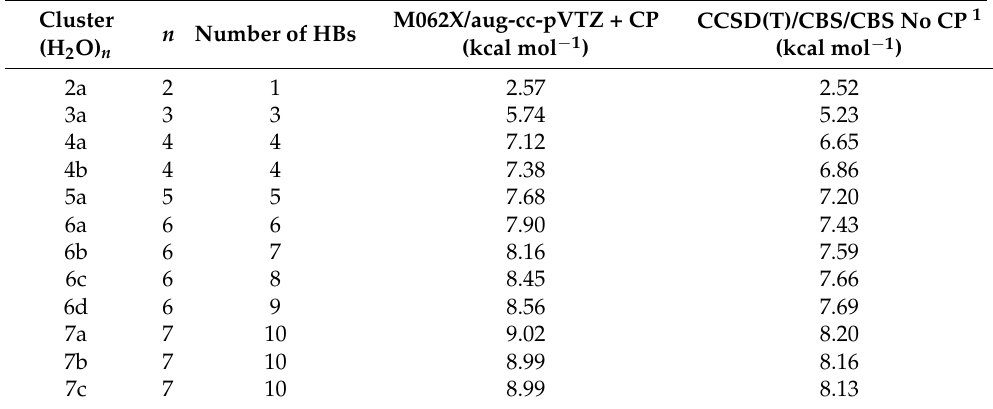
Table 1. Binding energy per water molecule in kcal mol − 1 for (H 2 O) n clusters, n = 2–7,